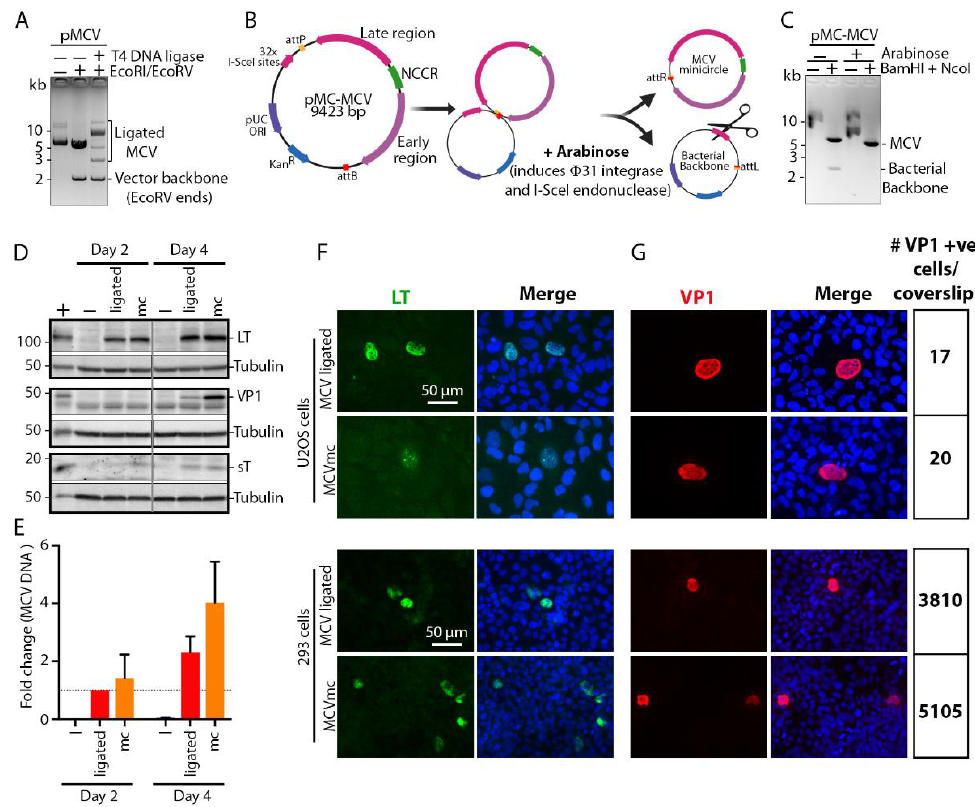
Figure 1. Development of a Merkel cell polyomavirus (MCV) molecular clone using minicircle (mc) technology. ( A ) Electrophoresis of MCV molecular clone re-circularized by T-4 DNA-ligase. DNA size markers are shown at the left of the gel image. ( B ) Schematic of recombinase-mediated re-circularization (minicircle technology) of MCV molecular clone (MCVmc). ( C ) Electrophoresis of MCV DNA extracted before and after recombination. DNA size markers are indicated at the left of the gel image. ( D ) Western blot of MCV-encoded proteins (LT, sT and VP1) from MCV-ligated and MCVmc-transfected 293 cells 2 and 4 days post transfection. Untransfected 293 cells were used as a negative control. The LT and VP1 expression constructs transfected in 293 cells were used as a positive control (indicated as +), while α -tubulin was used as an endogenous protein control. Protein molecular weight markers are shown on the left. The result is representative of three independent experiments. ( E ) Real-time PCR (qPCR) of the DpnI-resistant MCV genome from MCV-ligated or MCVmc-transfected 293 cells 2 and 4 days post transfection. Untransfected 293 cells were used as a negative control ( indicated as − ). The ΔΔCT method was used to determine MCV genome copy number fold change; GAPDH was used as an endogenous control, while the MCV-ligated 2 days post transfection group was used as the experimental control. Error bars indicate the ± SD of three independent experiments. ( F - G ) Immunofluorescence of LT-AF488 (pseudo color green), VP1-AF488 (pseudo color red) and DAPI (blue) in MCV-ligated and MCVmc-transfected 293 or U2OS cells 5 days post transfection. The numbers of VP1-positive cells per coverslip were counted with a Cytation 5 cell imaging multi-mode reader and are shown on the right. Images were originally acquired at 40× magnification.